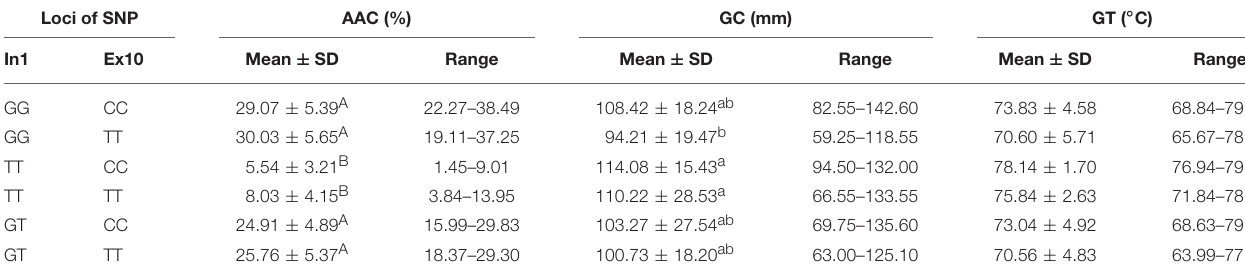
TABLE 5 | Rice ECQs for different haplotypes of In1G/T and Ex10C/T polymorphisms of Wx . Loci of SNP